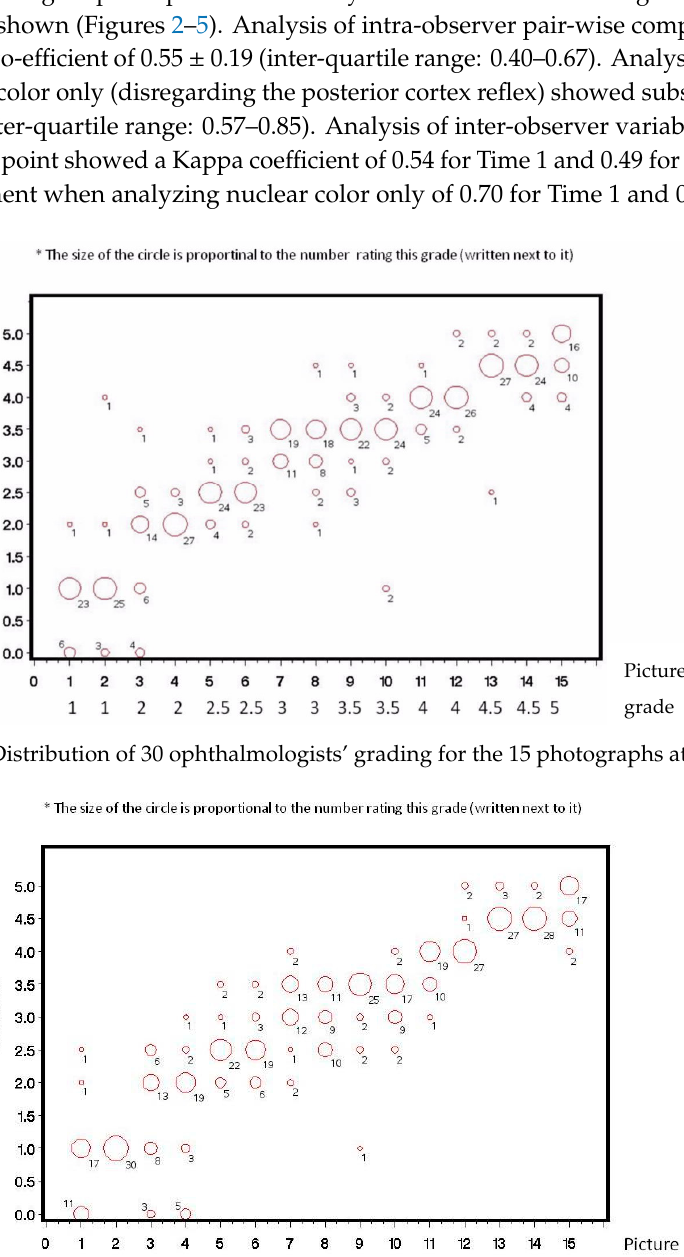
Figure 3. Distribution of 30 ophthalmologists’ grading for the 15 photographs at Time 2.